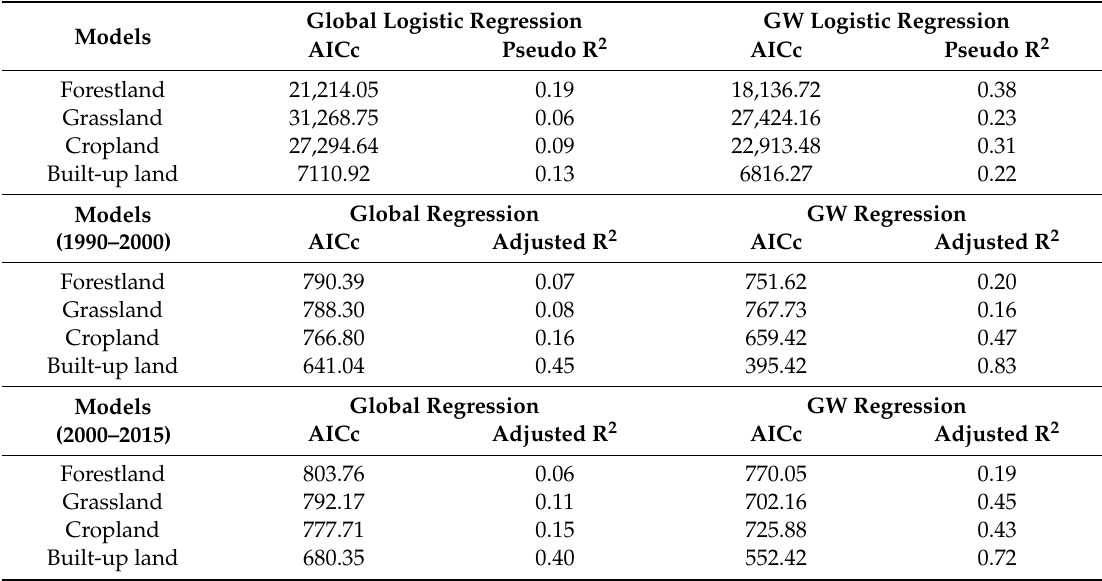
Table 3. Comparison of global and GW regression